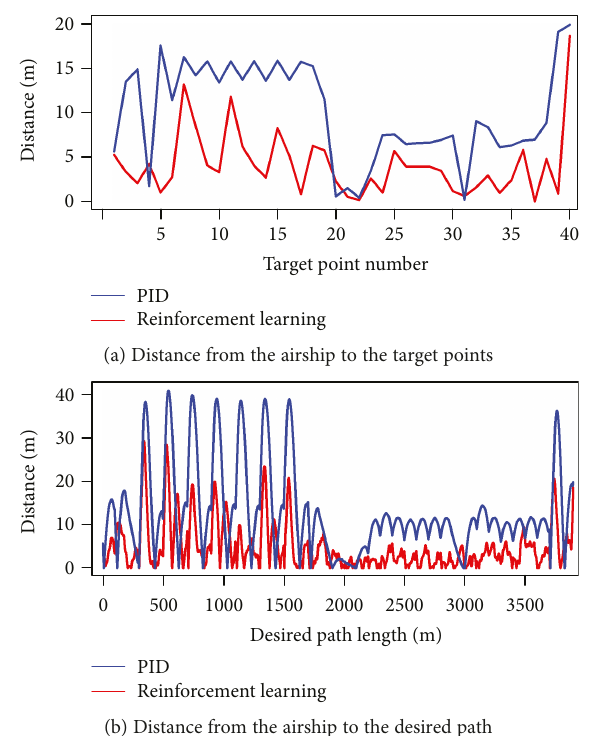
Figure 9: The deviation distance in the planar path-following control.